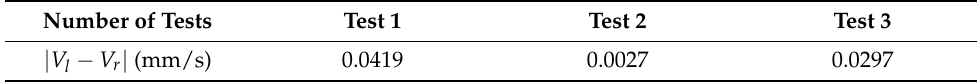
Table 2. Difference between wheel velocities.